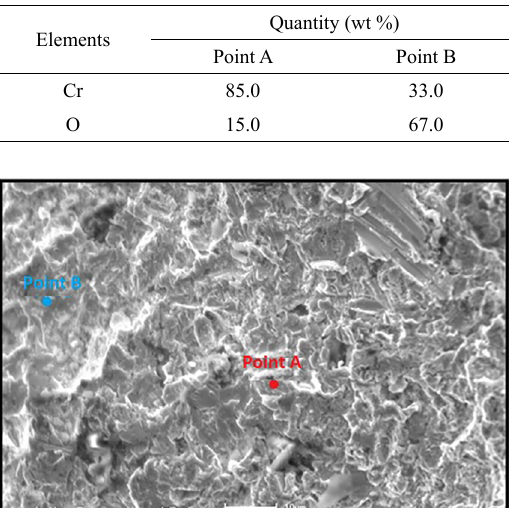
This is the sample 1 that is presented by the scanning electron microscopy (SEM) of magnification 1000X for the black chromium films. The surface topography reveals particles highly irregular in size and shape.